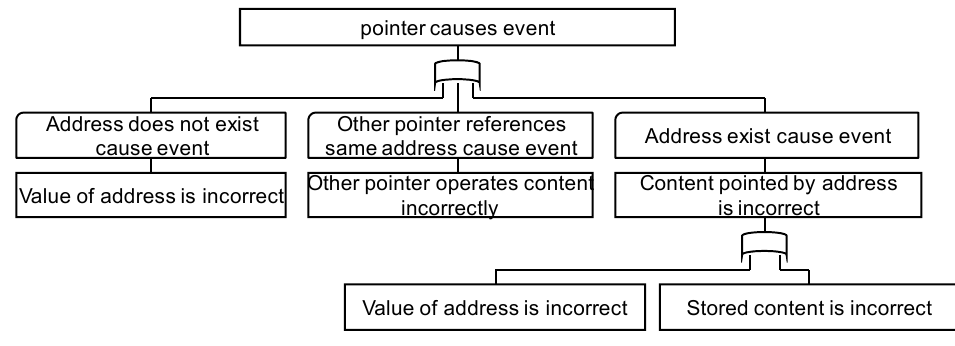
Figure 12. FTT for pointer.